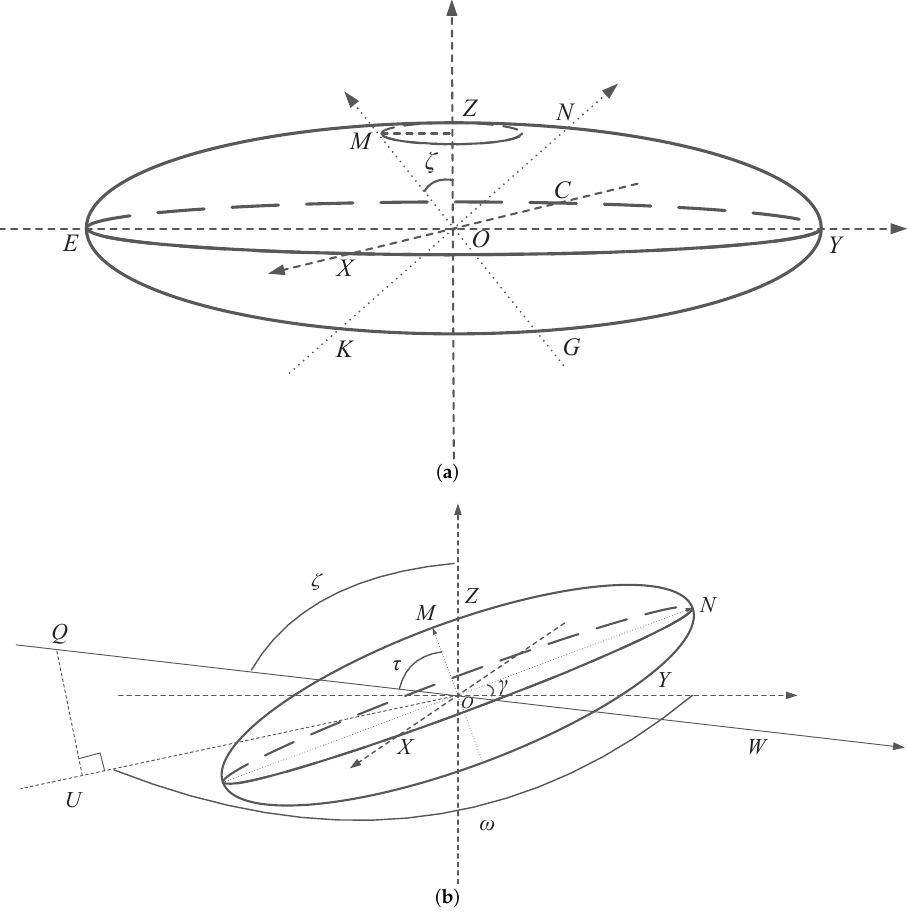
Figure 1. Anisotropy diagrams of turbulence cell for the horizontal and satellite links. ( a ) without anisotropic tilt angle γ ; ( b ) with anisotropic tilt angle γ